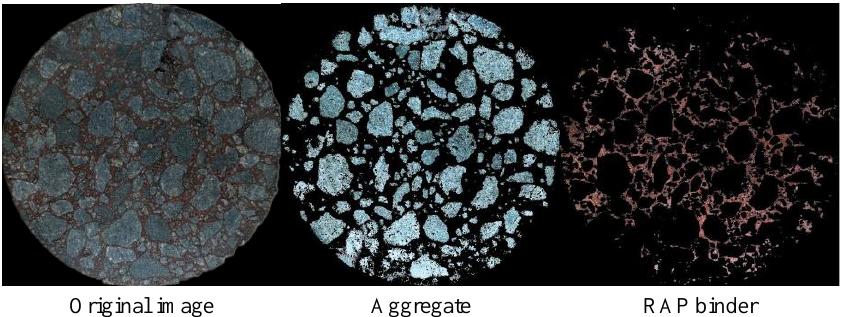
Figure 6. Montage of original image, aggregate, and RAP binder.